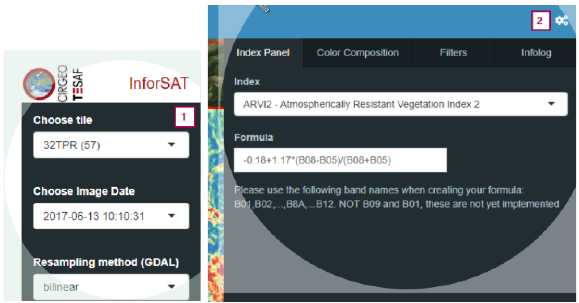
Figure 3. Left: drop down menus for choosing the tile (see Figure 2) and the specific date. The resampling menu on the bottom provides choices for resampling the output raster. Right: dropdown menu for choosing the index to be calculated, or the space for creating the user-defined index.